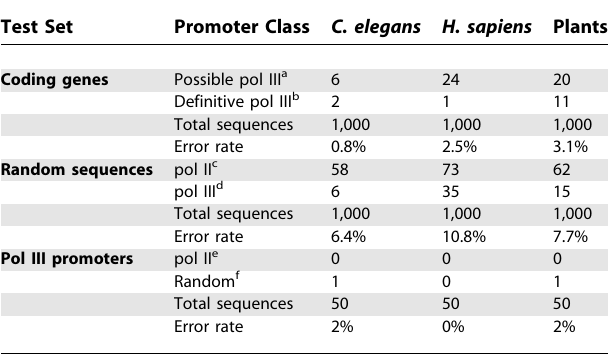
Table 5. Error Rates of SVM Models on Independent Test Sets Test